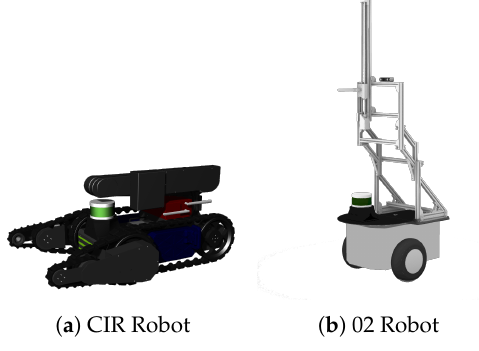
Figure 6. The CIR robot is equipped with a continuous track and extension arms, enabling going up and downstairs. The 02 robot is equipped with sensors and manipulators that allow elevator